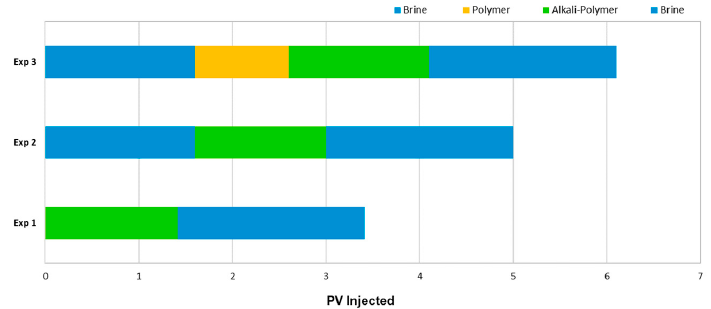
Figure 2. Summary of the injection sequences utilized for the different micromodel experiments.